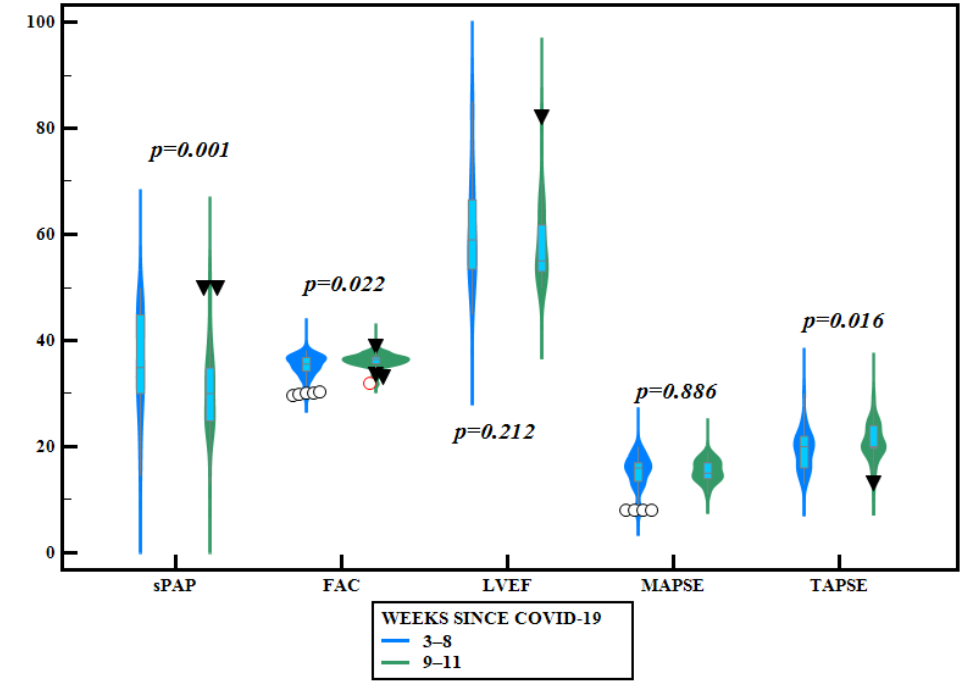
Figure 3. Violin plots comparing different echocardiographic parameters according to the time elapsed after COVID-19 infection (blue outline-plots = before 8 weeks since COVID-19 infection; green outline plots = after 8 weeks since COVID-19 infection). Table 3. Comparison between subjects according to the time elapsed from the COVID-19 diagnosis until TTE and liver elastography.